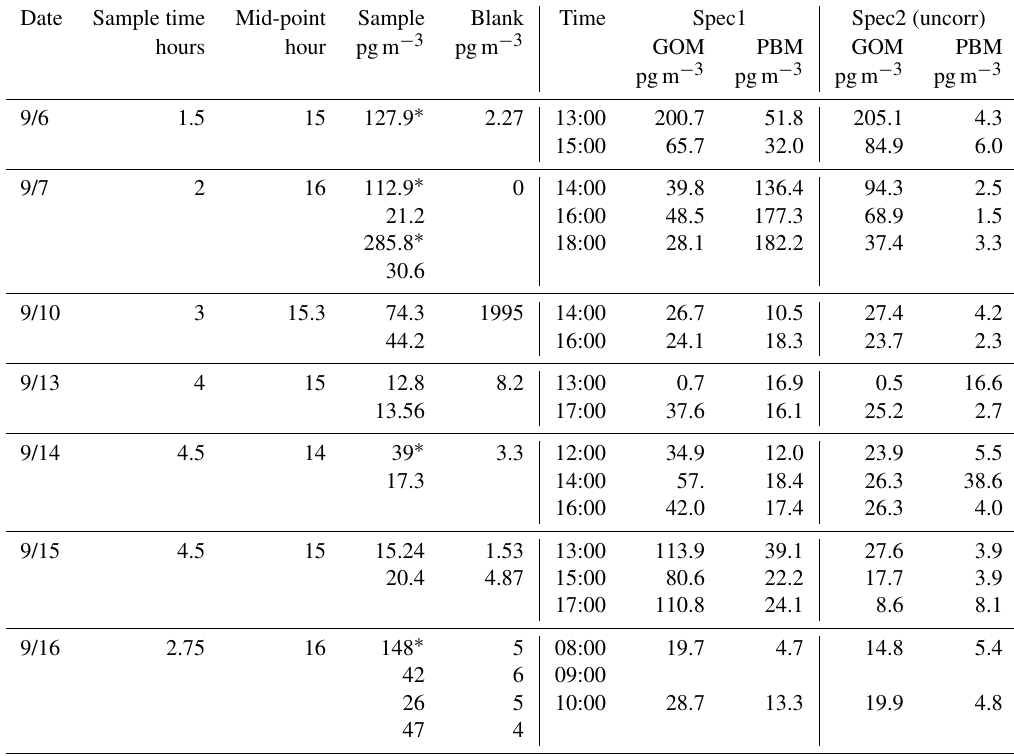
Table 1. RAMIX manual KCl denuder sampling. Date Sample